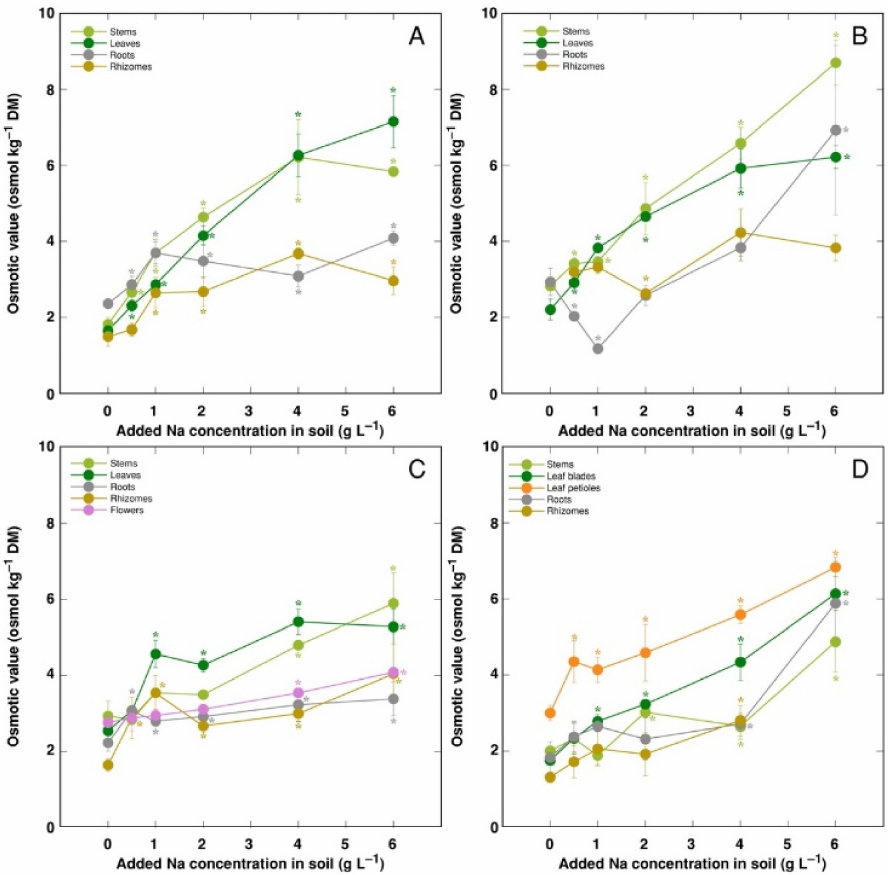
Figure 9. Changes in total osmotic value under the effect of increasing soil salinity in different parts of Calystegia sepium accessions CSe1 ( A ), CSe2 ( B ), CSe3 ( C ) and Calystegia soldanella ( D ). Na + was added in a form of NaCl. Data are means from three replicates for each concentration ± SE. Asterisks of the respective color indicate statistically significant differences ( p < 0.05) from